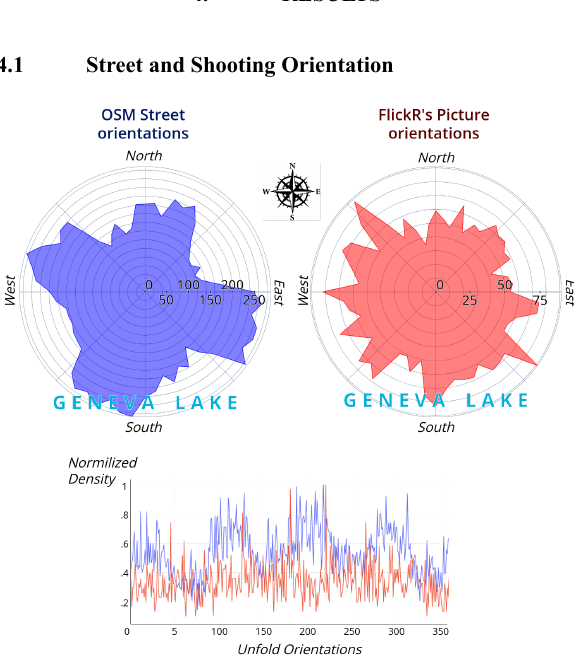
Figure 3: Visualization of polar data for the city of Lausanne. On the left of the diagram are the street orientations; on the right, the FlickR’s photograph orientations. The circular representation shown on top has been normalized and unfolded on a line graph between 0 and 2 𝞹 (bottom